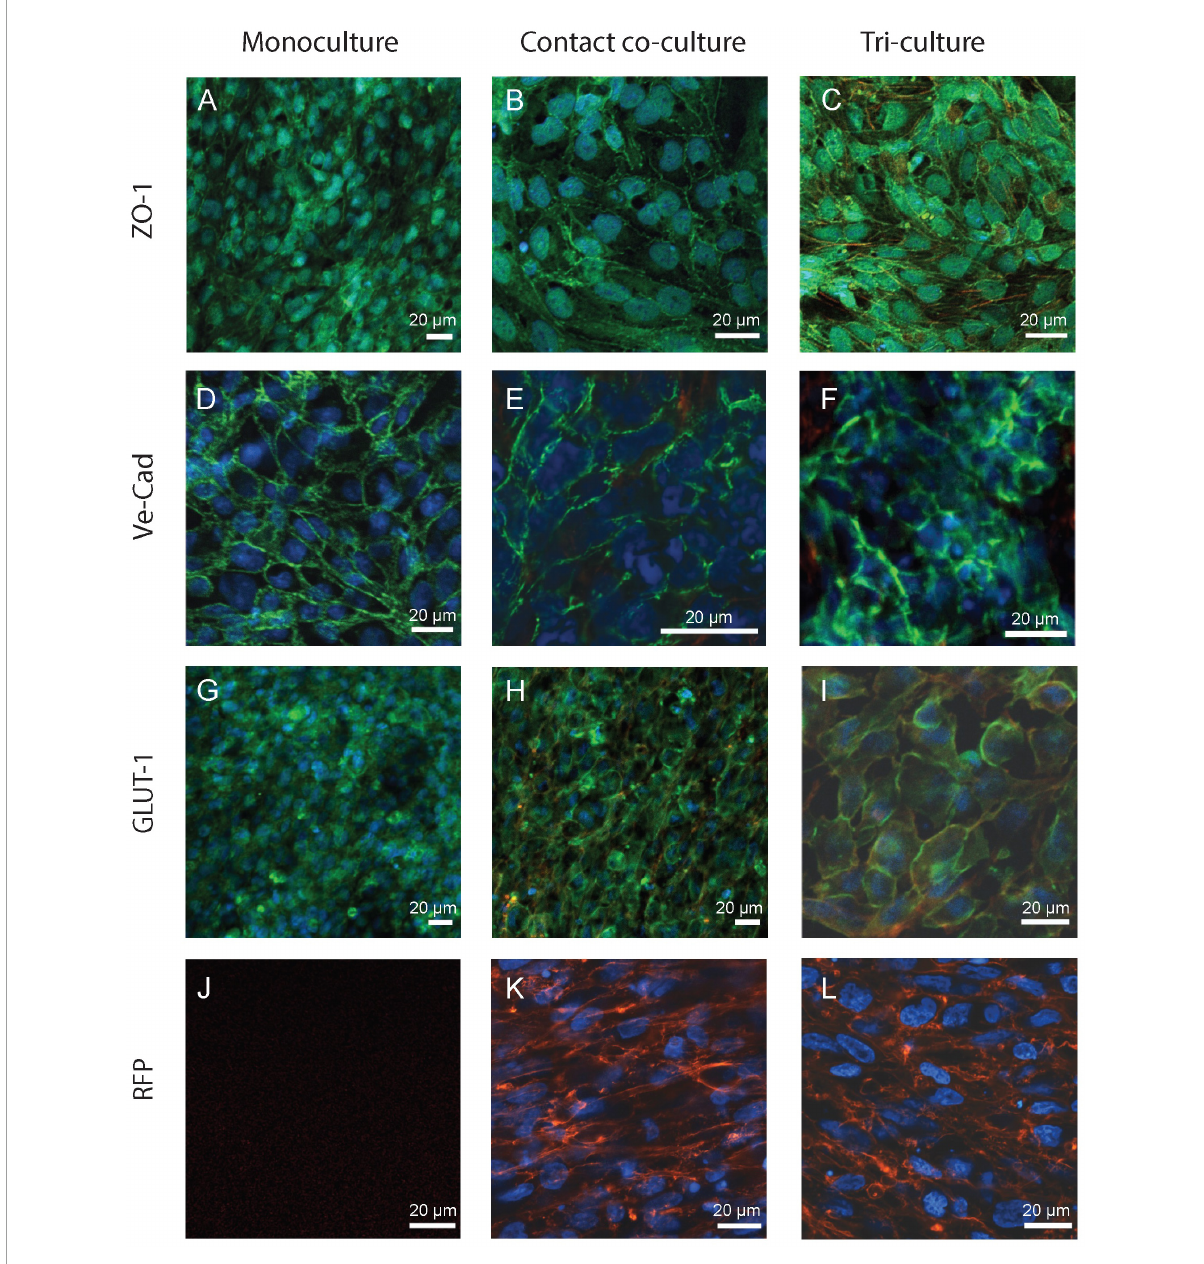
FIGURE3 Fluorescence images of the in vitro BBB in the monoculture (left), co-culture (i.e., “contact” co-culture, center) and tri-culture configurations (right). Images were acquired from the insert porous membrane where endothelial cells and astrocytes were seeded and cultured as described in Section “Cell culture.” Cells were immunostained for key biomarkers representative of barrier integrity and glucose transport activity: (A–C) ZO-1, (D–F) VE-Cad, and transporters expression (G–I) GLUT-1. Cells were stained for each protein using AlexaFluor488 (green) and nuclei counterstained with Hoechst (blue). (J–L) Astrocytes were transfected with red fluorescent protein (RFP+), but they are absent in the monoculture condition (J) . Scale bar 20 µ